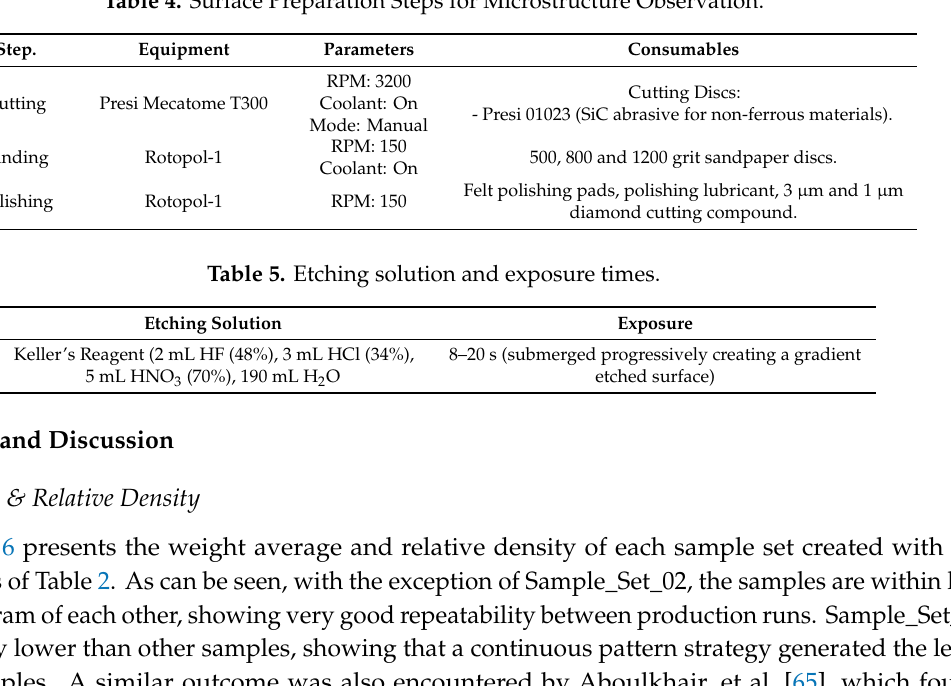
Table 4. Surface Preparation Steps for Microstructure Observation.